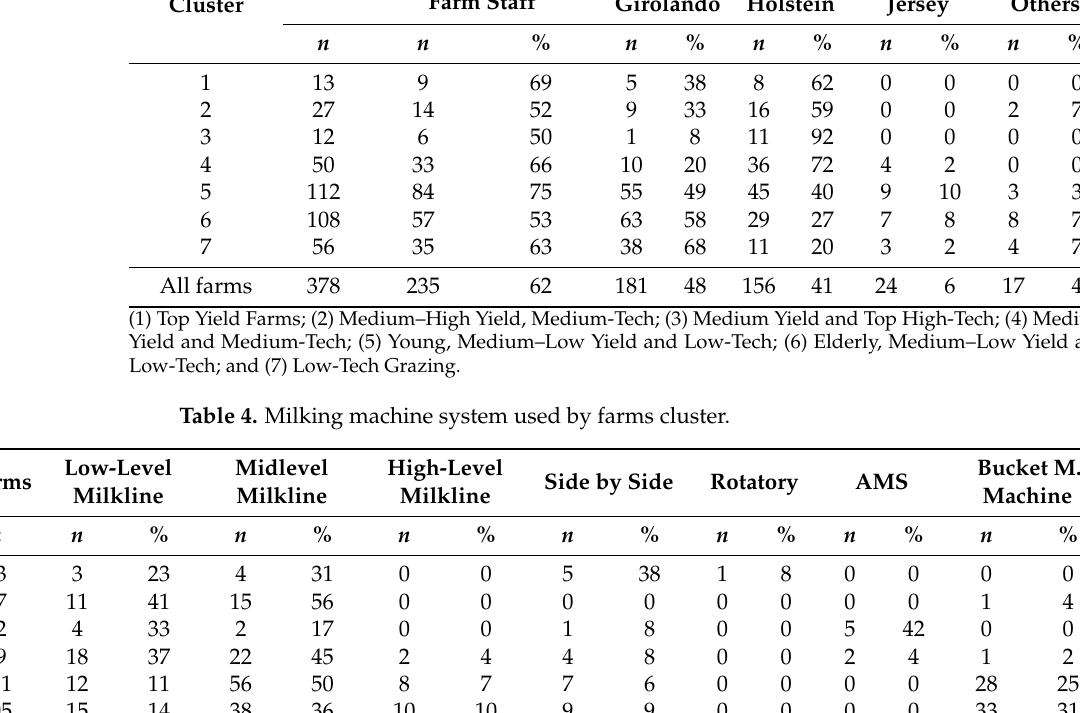
Table 3. Percentege of farms that the owner is part of staff and breed used by farms clusters. Breed Owner Is Part of Farms Farm Staff Girolando Holstein Jersey Others Cluster n n % n % n % % 1 0 0 0 2 27 14